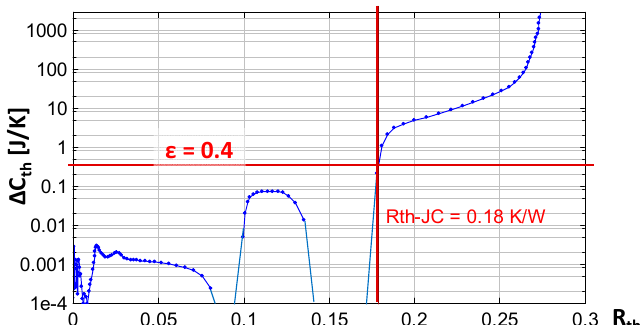
Figure 10. Difference of structure functions belonging to TIM thermal conductivities of 4 W/mK and Figure 10. Di ff erence of structure functions belonging to TIM thermal conductivities of 4 W / mK and 0.2 W / 0.2 W/mK.